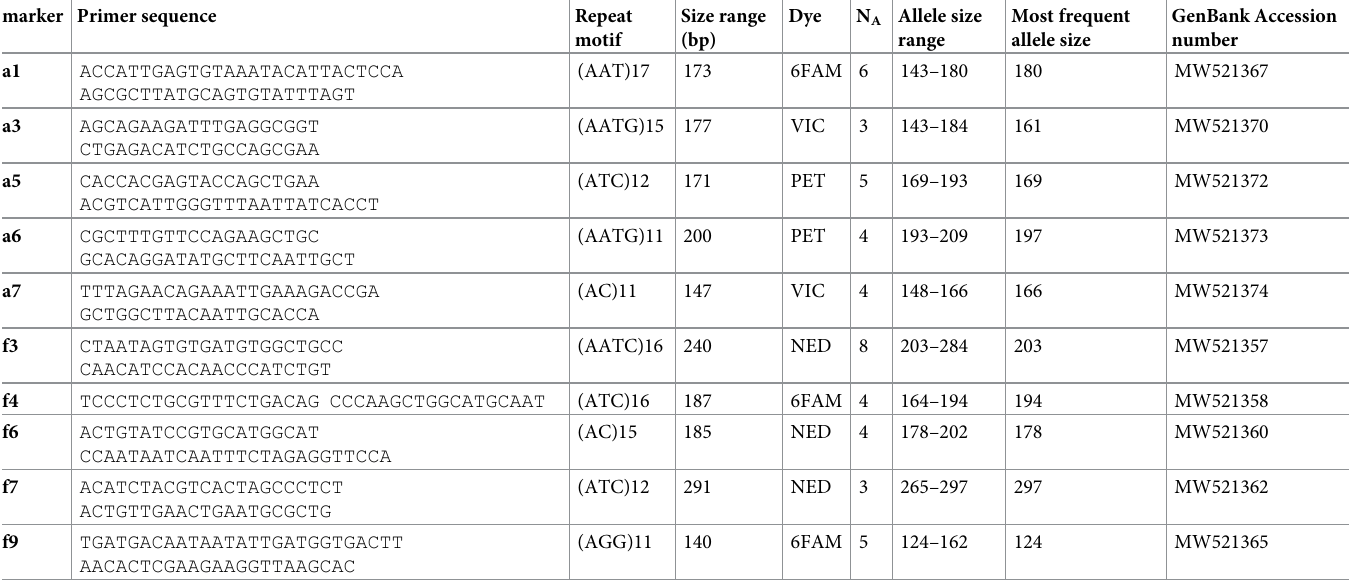
Table 1. Characterization of microsatellite loci isolated from E . andrei (a) and E . fetida (f) used in present paper. marker Primer